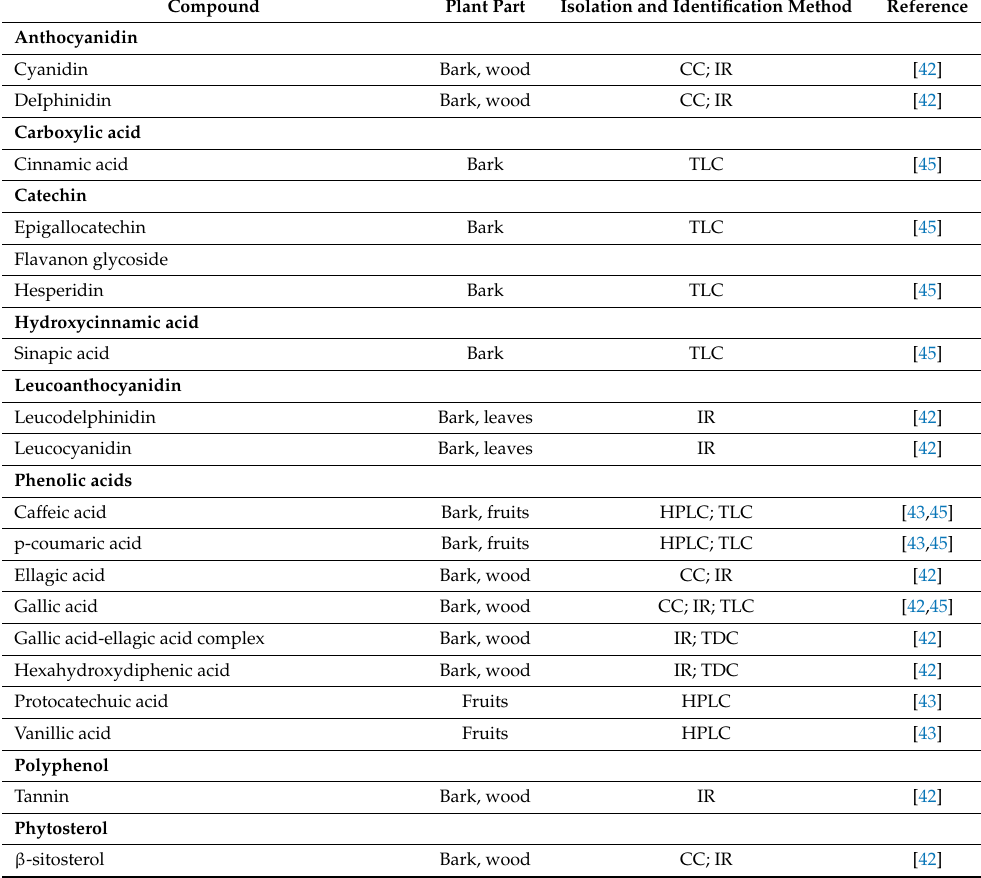
Table 3. Chemical compounds isolated and characterized from Syzygium